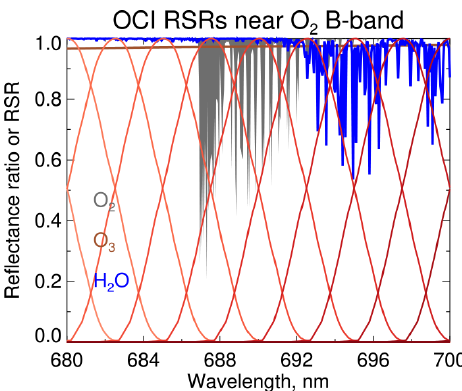
Figure 3. As Fig. 1 except for OCI channels in the region of the O 2